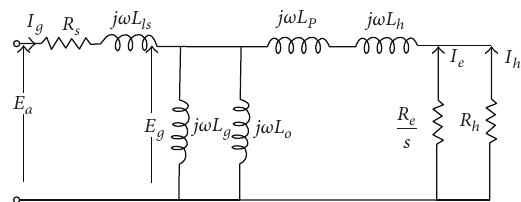
F 4: A hysteresis motor model in rotating qd0 reference frame. thickness of hysteresis